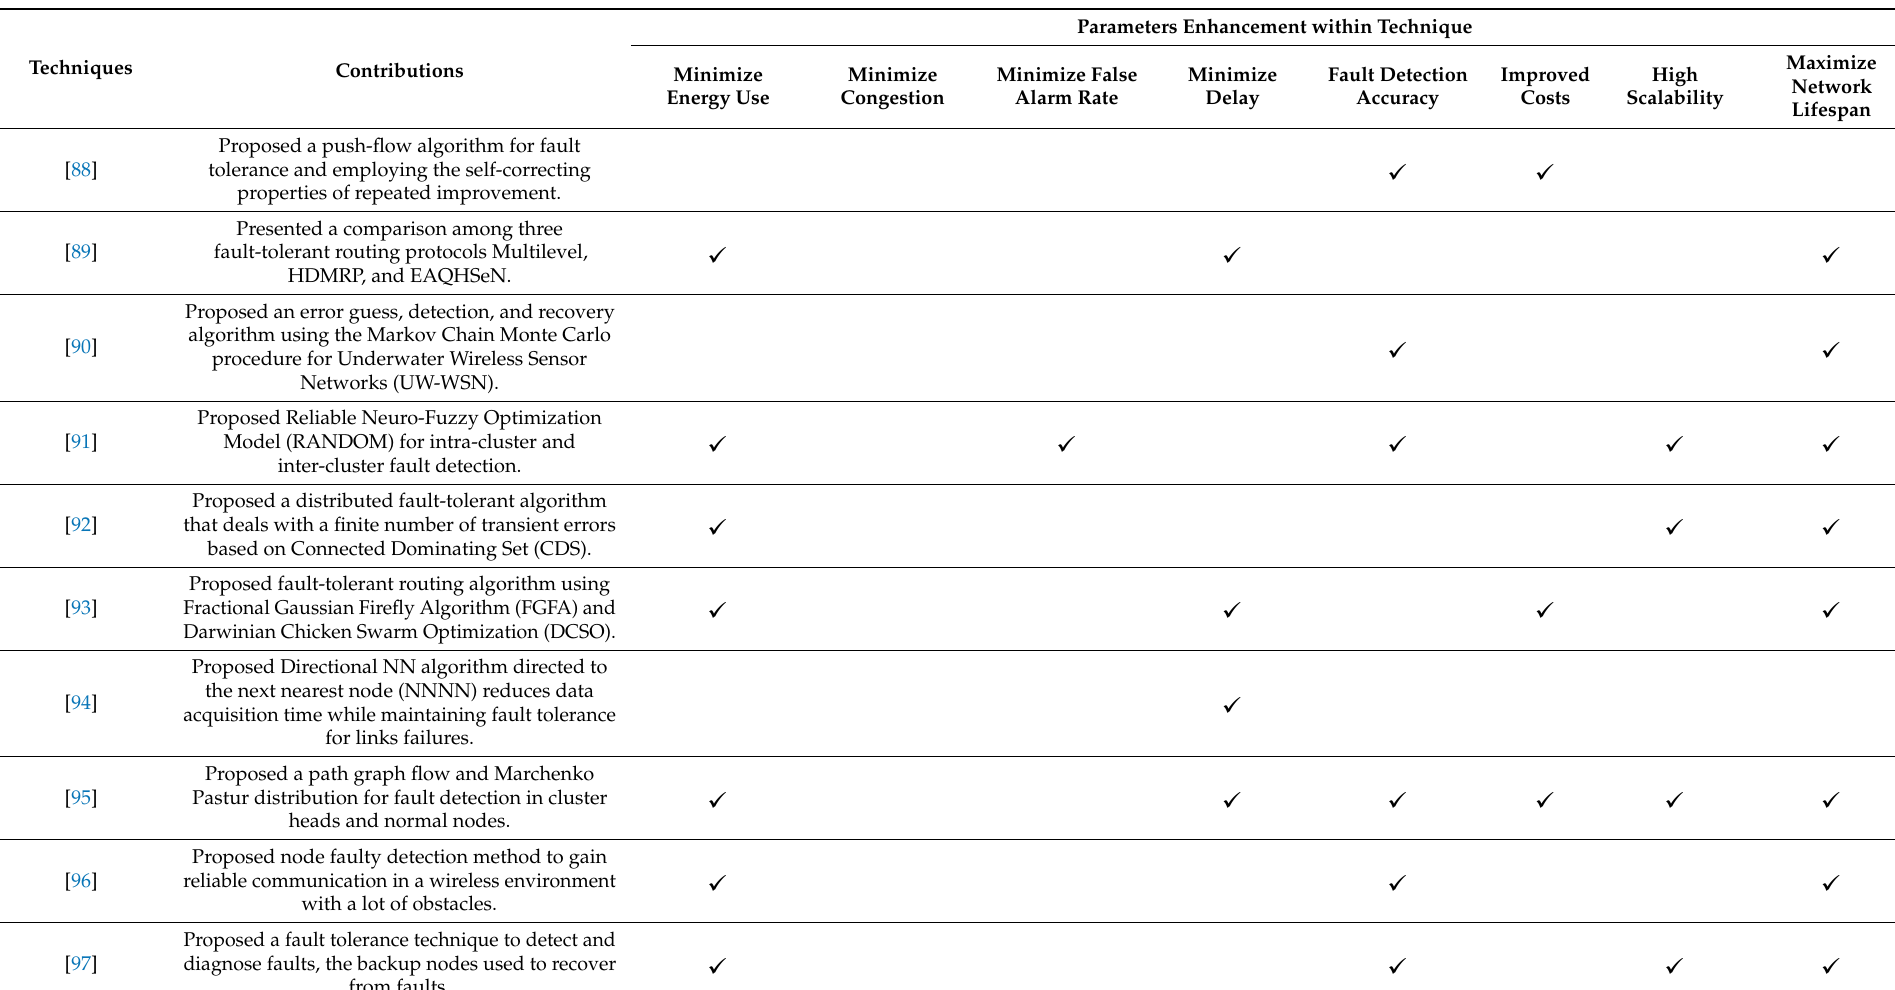
Table 1. Surveys on Fault-Tolerant in WSNs.